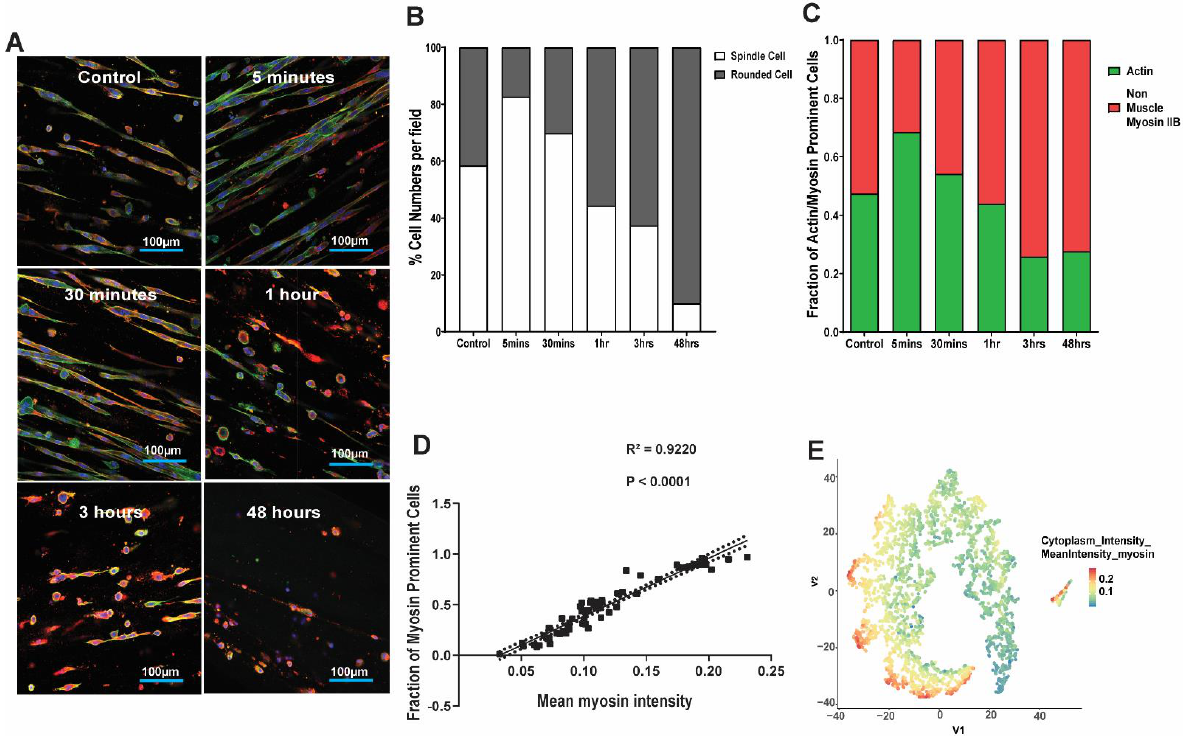
Figure 5. Kinetics of lung fibroblast cytoskeleton and morphological alterations following mechanical strain. Human fetal lung 1 (HFL1) fibroblasts were embedded in 3D collagen-1 gels of 2.0 mg/mL concentrations and cultured for 24 h. The HFL1 fibroblast-seeded collagen gels were then left alone or mechanically strained for 48 h at a 1% amplitude and a frequency of 0.2 Hz. Gels were collected after 0, 5, and 30 min, and 1, 3, and 48 h, following the stain protocol. ( A ) Representative confocal images of HFL1 fibroblasts in 2.0 mg/mL collagen-1 gels stained for non-muscle myosin IIB (red) and F-actin (green) after mechanical strain experiments at different time points. ( B ) Percentage cell numbers of spindle and rounded shaped cells at different time points in 2.0 mg/mL collagen-1 gels after being strained at different time points. ( C ) Percentage positive pixel count per total number of pixels in images of 2.0 mg/mL collagen-1 gels after being strained at different time points. ( D ) The correlation between the fraction of myosin prominent cells and the mean myosin intensity in images of 2.0 mg/mL collagen-1 gels after being strained at different time points. ( E ) TSNE-plot visualiza- tion of each single cell with the 2.0 mg/mL collagen-1 gels after being strained at different time points. Mean stacked bar graphs are shown for 3 technical replicates, n = 6 in ( B , C ).